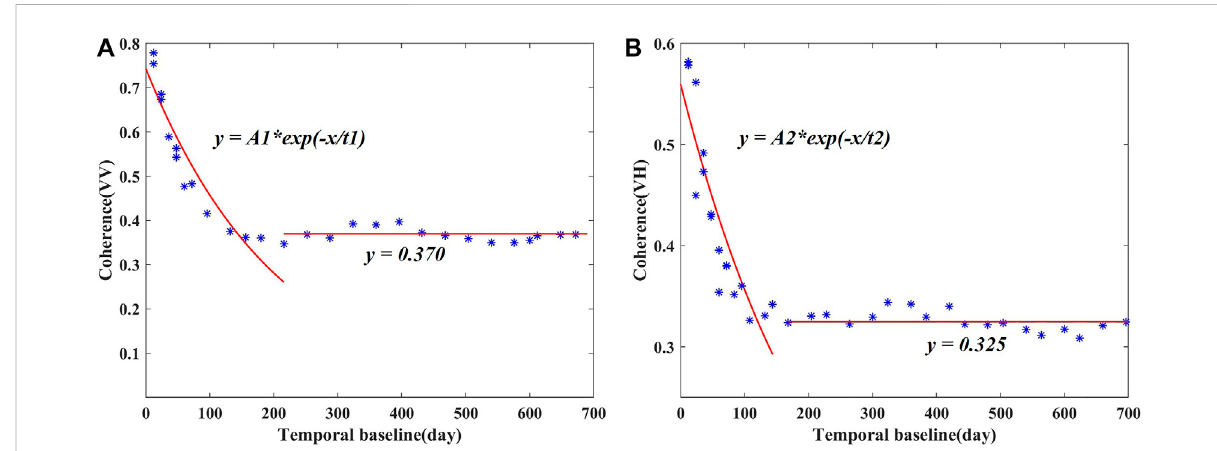
FIGURE 5 Relationship between the temporal baseline and coherence (A) VV channel (B) VH channel.